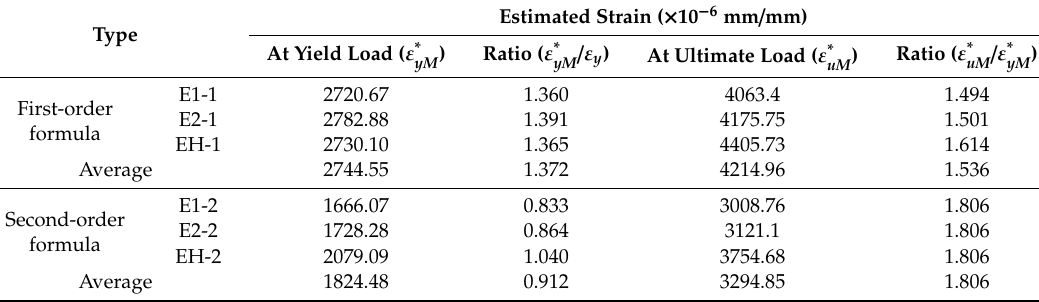
Table 6. Estimated strains of the modular specimen at the yield and ultimate